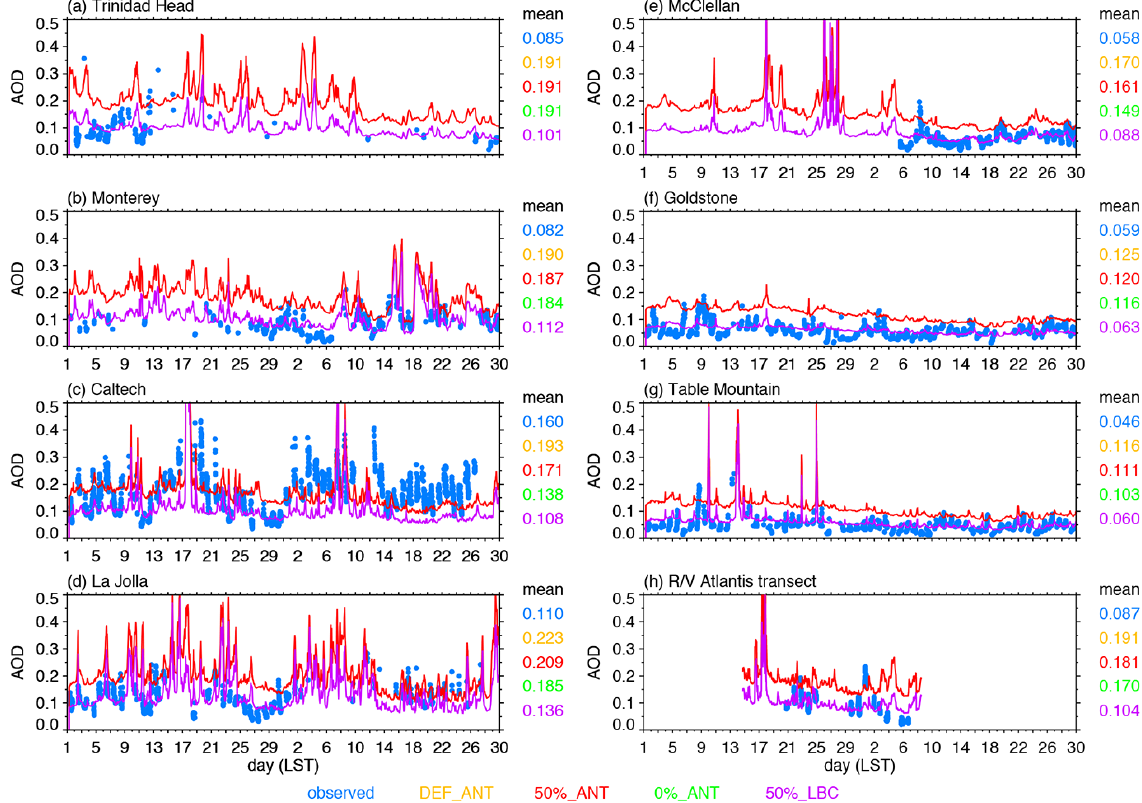
Figure 26. Observed and simulated AOD at 500nm at the (a) Trinidad Head, (b) Monterey, (c) Caltech, (d) La Jolla, (e) McClellan, (f) Goldstone, and (g) Table Mountain AERONET sites depicted in Fig. 1d and (h) along the R/V Atlantis transect depicted in Fig. 1a. Average values over the 2-month period are given to the right of each